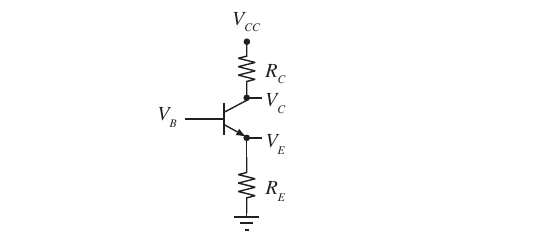
FIG. 1. The canonical BJT common-emitter amplifier circuit. The base, collector, and emitter voltages have been labeled ( V B , V C , and V E , respectively) for clarity.